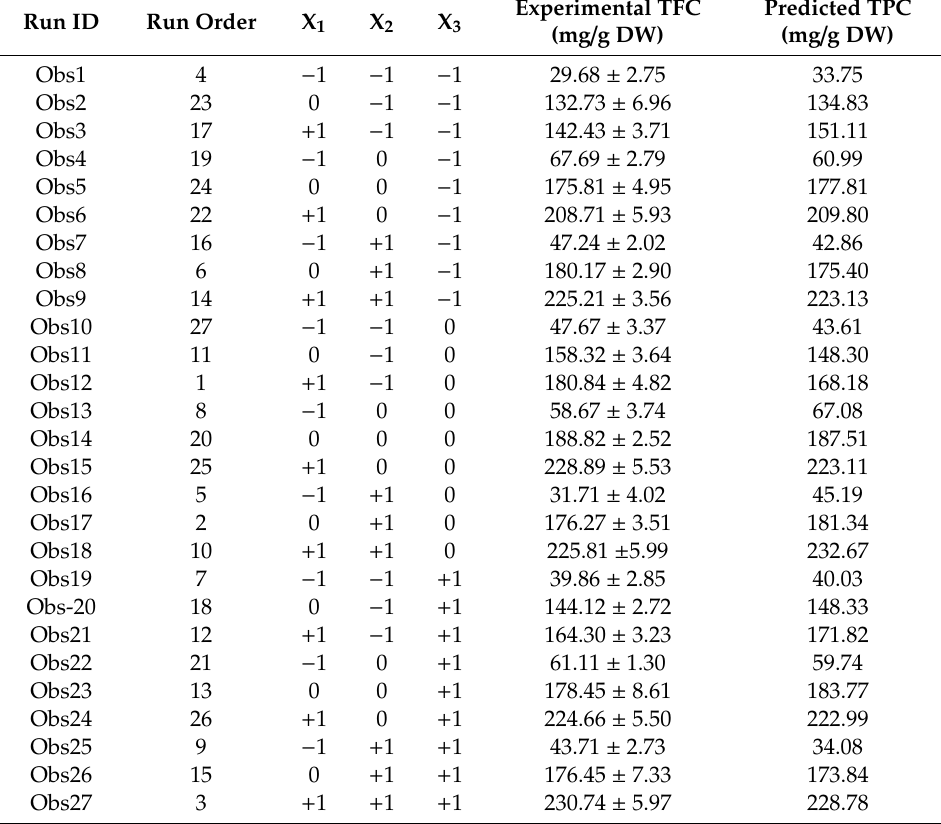
Table 3. Results of full factorial design experiments for the UAE of TFC from N. lotus stamens.